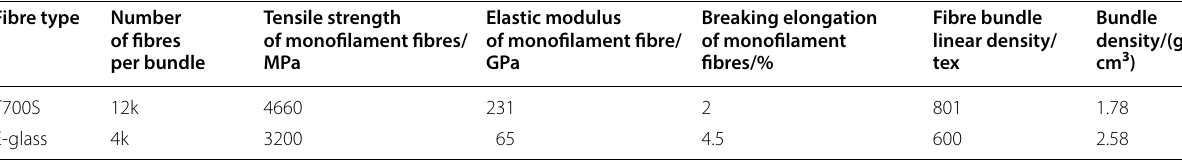
Table 2 Mechanical properties of textile.